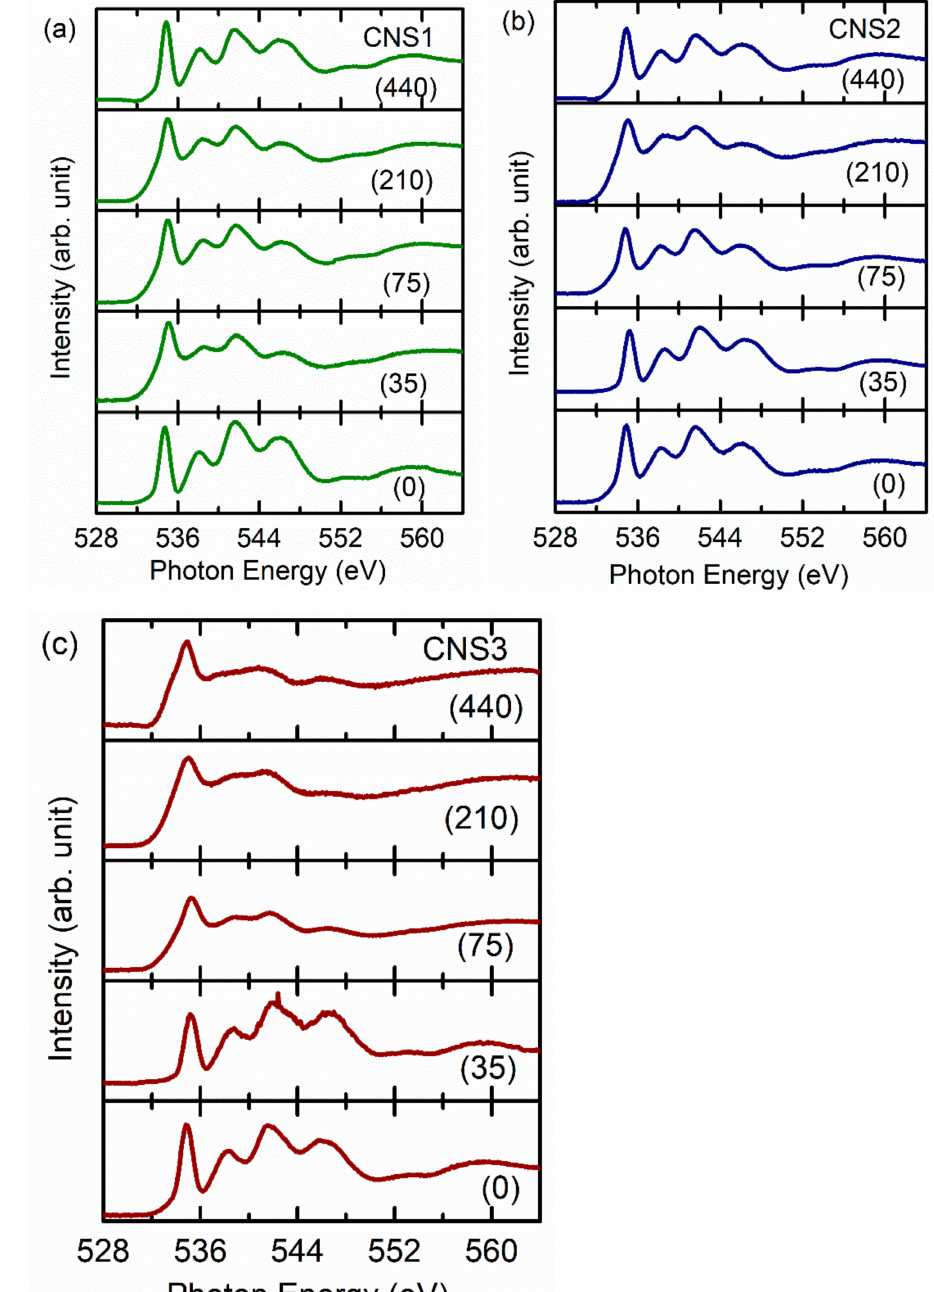
Figure 9. O K -edge NEXAFS spectra of ( a ) CNS1, ( b ) CNS2, and ( c ) CNS3. Numerals 0, 35, 75, 210, and 440 are the number of days to which nanocrystals were exposed to an open environment. This behavior is associated with the surface reconstruction caused by the absorbed molecules from the environment on the particle surfaces [29,30,54]. The adsorption process not only depends on the surface energy but also on the energy of an adsorbed